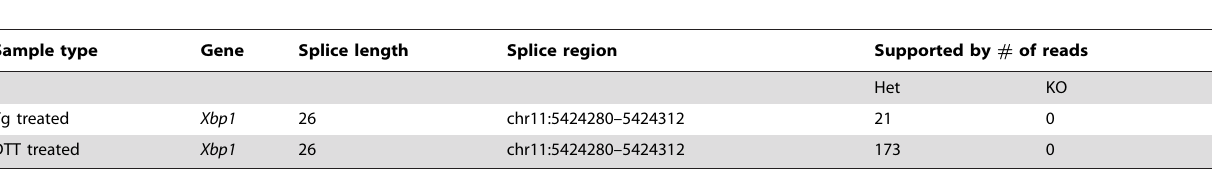
Table 2. The number of reads aligned to Xbp1 ’s 26 bp splice junction by our ‘‘Read-Split-Walk’’ (RSW) algorithm for Ire1 a + / 2 and Ire1 a 2 / 2